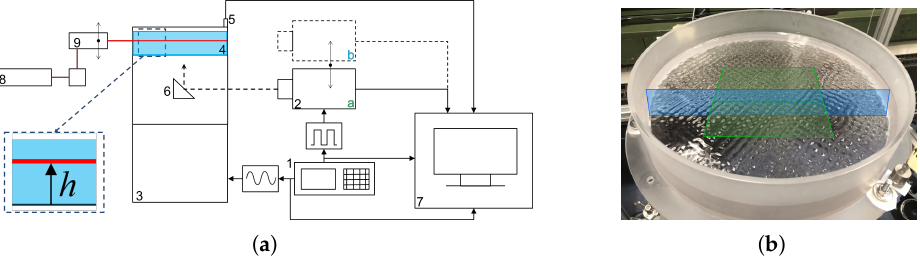
Figure 1. ( a ) Schematics of the experimental setup for the horizontal- and vertical-plane PIV mea- surements, respectively. The zoom-in region shows the location of the horizontal planes measured as distance from container bottom, height h . ( b ) Pattern of Faraday waves on the fluid at forcing frequency f f = 50 Hz. The green and blue planes qualitatively indicate the position of the laser sheet for the horizontal and vertical PIV measurements,